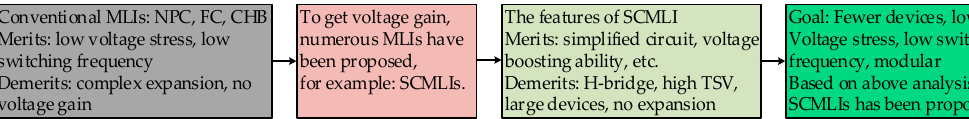
Figure 1. The procedure of developing the multilevel inverter.